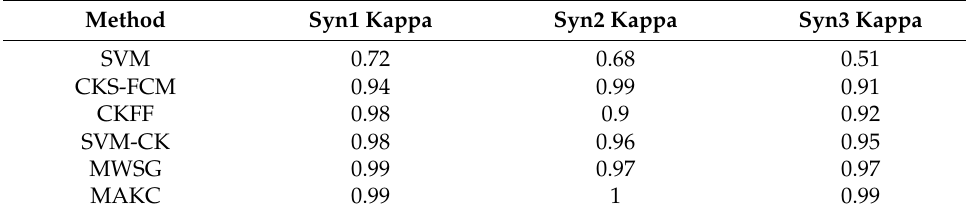
Table 2. Kappa coefficients of different algorithms on the synthetic SAR images.